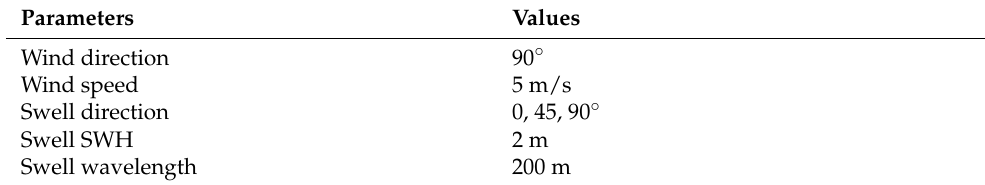
Table 6. The input parameters of ocean waves.